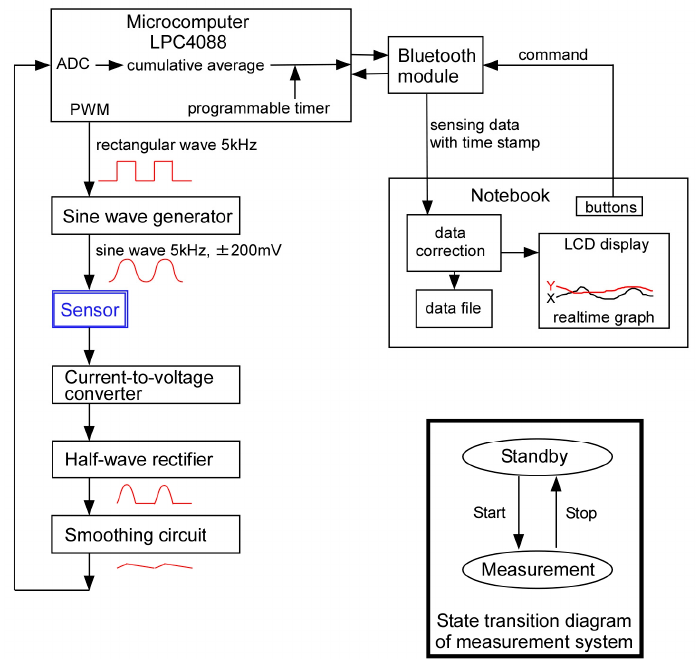
Figure 3. Block diagram of the measurement system. ADC: analog to digital converter; PWM: pulse width modulator.